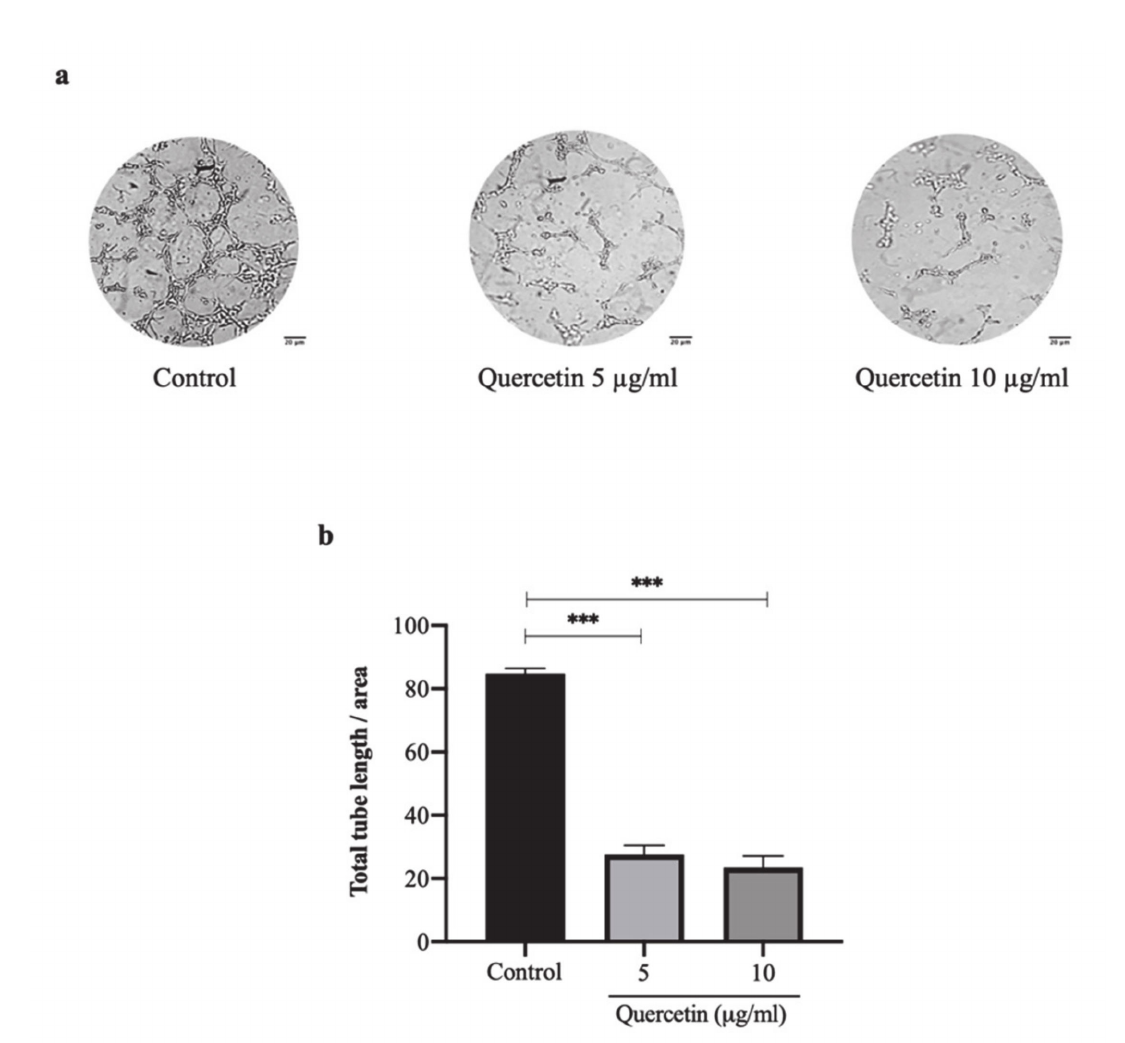
Figure 2. Quercetin inhibits HT-29 cells-induced tube formation of HUVECs. HUVEC cells were incubated with HT-29 cells conditioned media with or without quercetin for 6 h. The pictures revealed tubular morphology of HUVECs on the Matrigel layer ( a ) Scale bar: 20 µ m. Total tube length was measured and analyzed by ImageJ program with angiogenic analyzer which represented as bar graph ( b ), mean ± SD, n = 3, *** p <